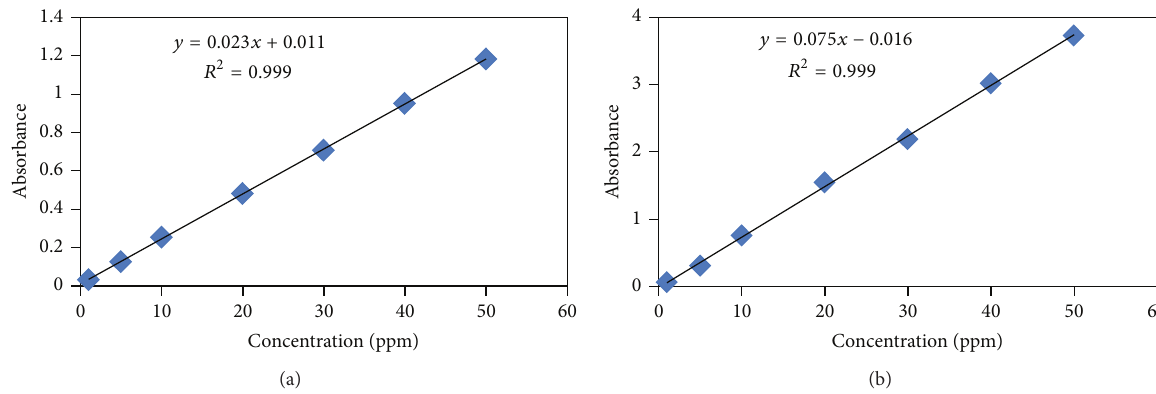
Figure 6: (a) Calibration curve of basic orange dye. (b) Calibration curve of methyl violet